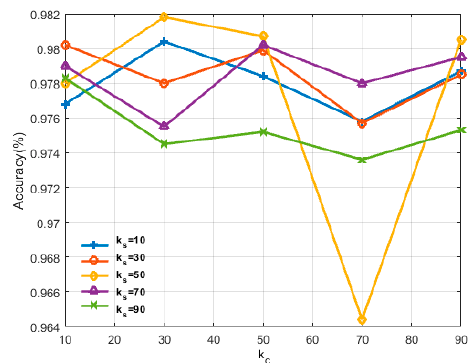
k k Figure 7. E ff ect of k c and k s on the classification Figure 7. Effect of c and s on the classification accuracy.